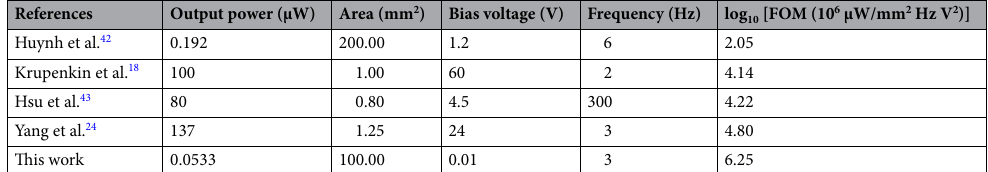
Table 3. Figure-of-merit (FOM) in logarithmic scale of various REWOD energy harvesting technologies demonstrated in the past and this